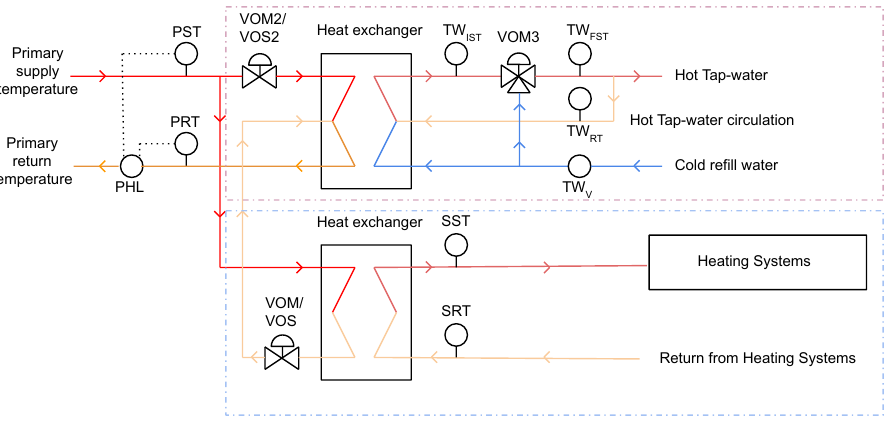
Figure 3. HVAC&R system schematics: dashed purple rectangle represents the tap-water sub-system, and dashed blue rectangle represents heating systems.